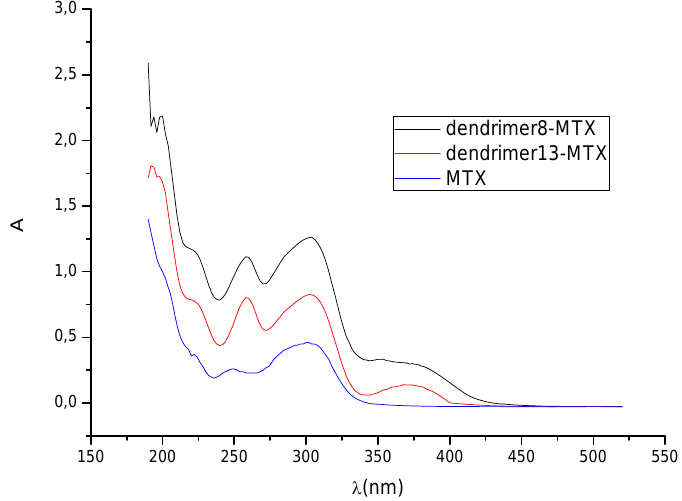
Figure 2. UV-VIS spectra of dendrimer8-MTX and dendrimer13-MTX complexes and MTX in deionized water. The relative concentrations with regard to MTX in water are 2.71 to 13 -MTX complex and 4.14 to 8 -MTX complex.